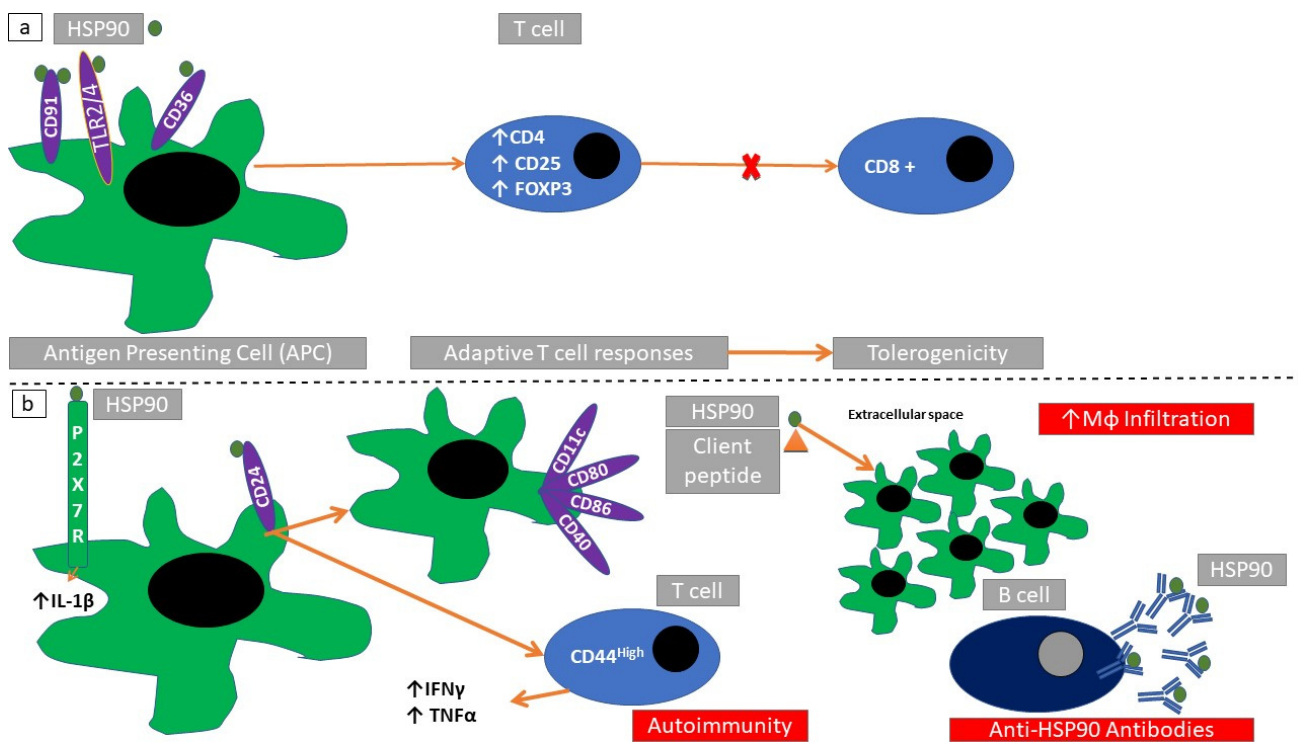
Figure 5. Immunomodulatory actions of HSP90. ( a ) Through binding with specific receptors (TLR2/9, CD36, and CD91) on antigen-presenting cells, HSP90 blocks cytotoxic T-cell expansion (CD8+) and induces adaptive T-cell responses. ( b ) Through binding with specific receptors (ATP-gated P2X cation channel receptor, P2X7R) HSP90 induces the production of proinflammatory cytokines (IL-1 β ). Binding to CD25 can induce macrophage activation and further propagate immunoreactive T-cell responses. This can be followed by macrophage recruitment and anti-HSP90 antibody production.